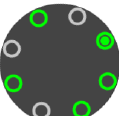
Figure 2. Control visible to user, with which it was required to